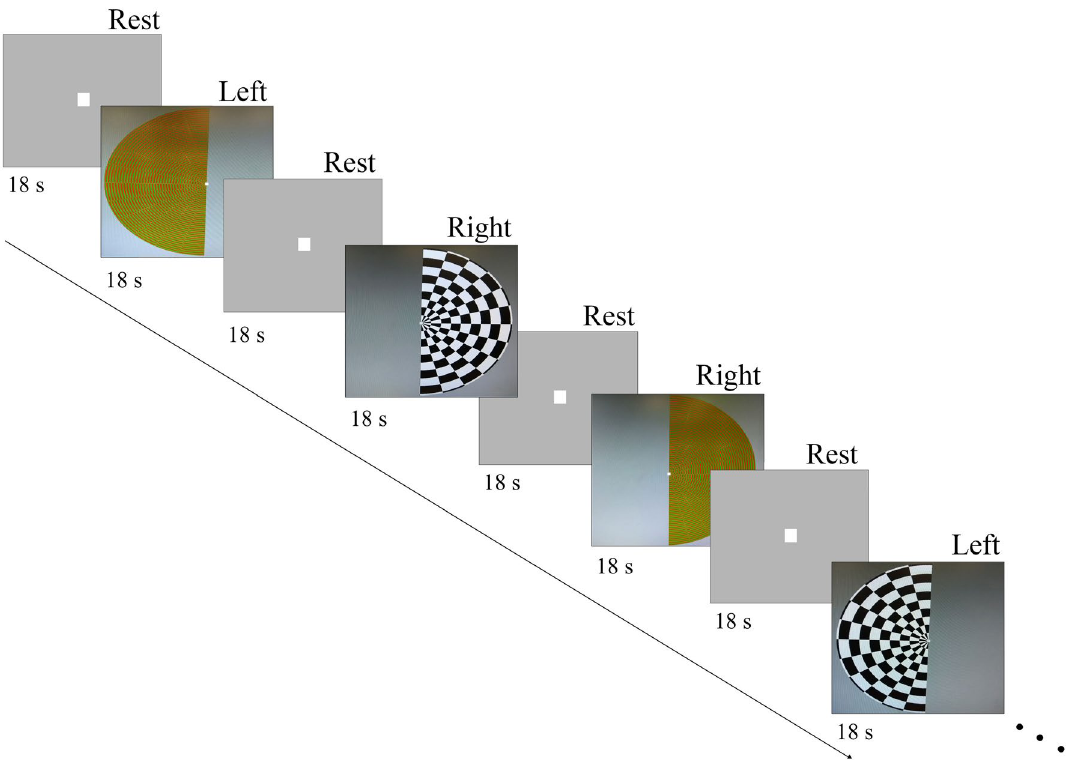
Figure 8. Visual stimulation task protocol. Visual stimuli comprise Right and Left hemifield reversing checkerboards spaced out by 18 s rest